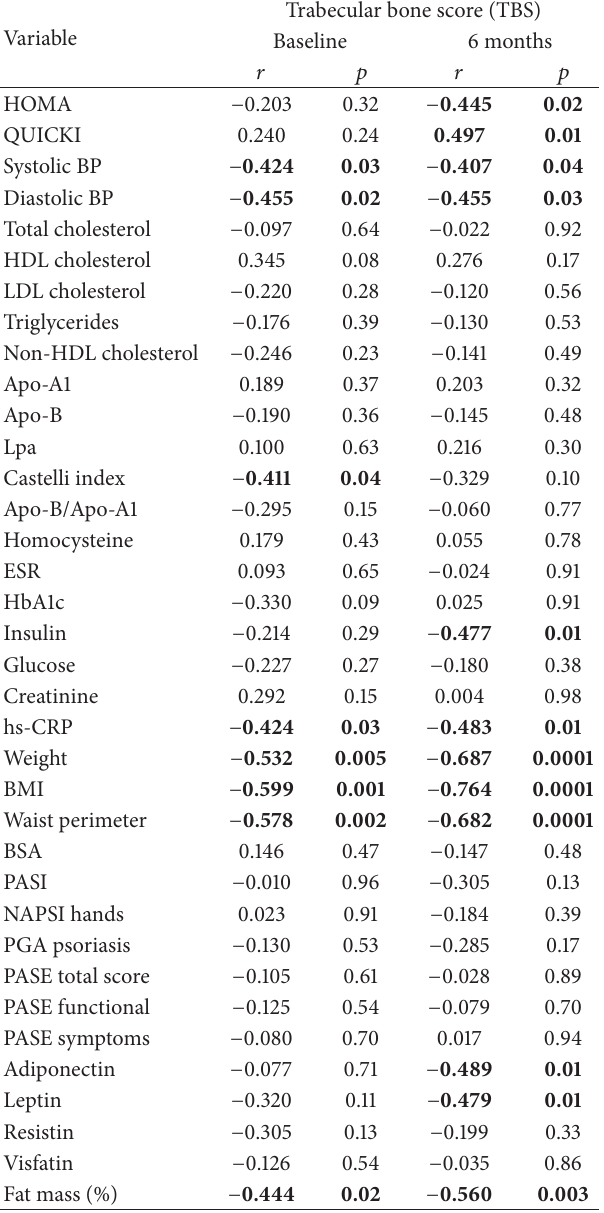
Table 3: Partial correlations of TBS prior to adalimumab (baseline) and after 6 months of TNF- 𝛼 blockade, in 29 patients with moderate to-severe psoriasis ∗